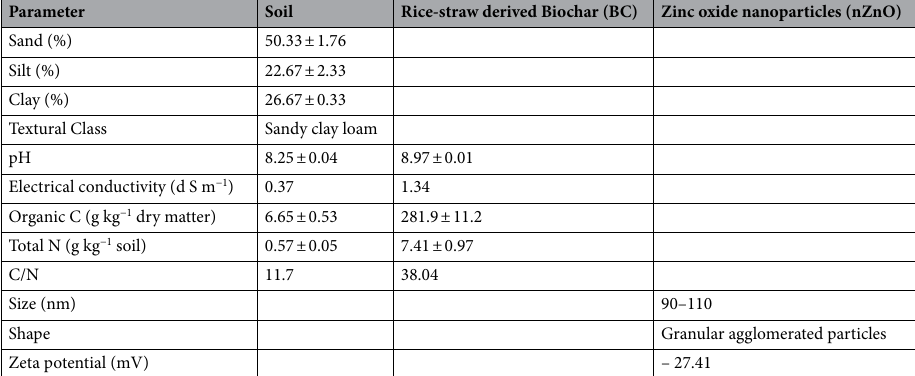
Table 1. Pre-incubation physiochemical characteristics of soil, rice-straw derived biochar (BC) and zinc oxide nanoparticles